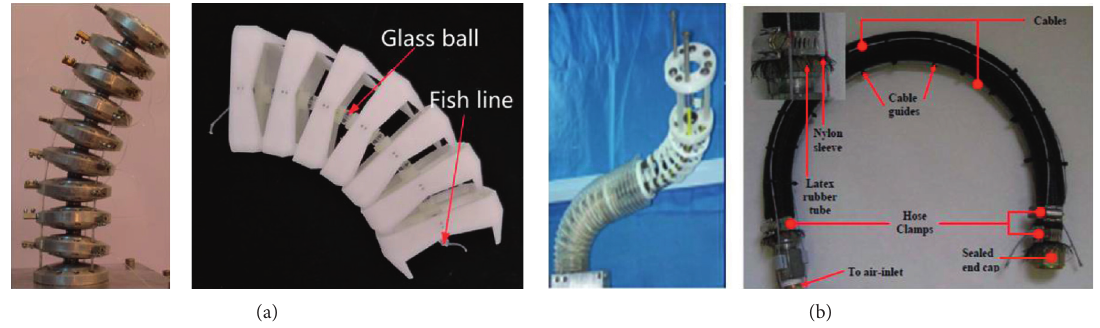
Figure 3: Single-segmented and multidisc continuum robots: (a) spine [40, 53] and (b) snake inspired [65,